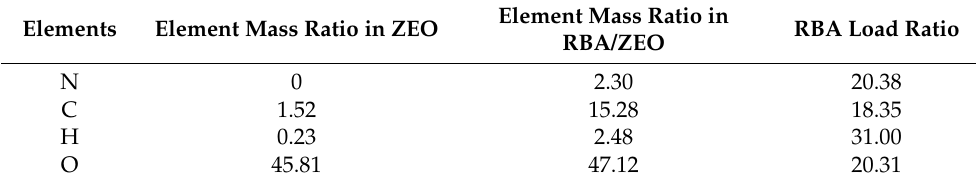
Table 1. RBA load ratios (%) derived from N, C, H and O elements.